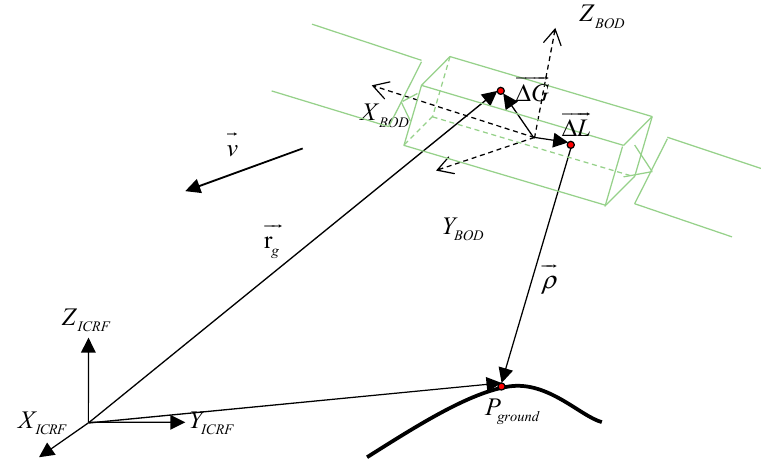
Figure 5. The geometrics of the spaceborne laser altimeter.